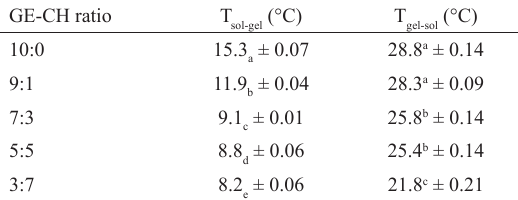
and T of gel forming sol–gel gel–sol